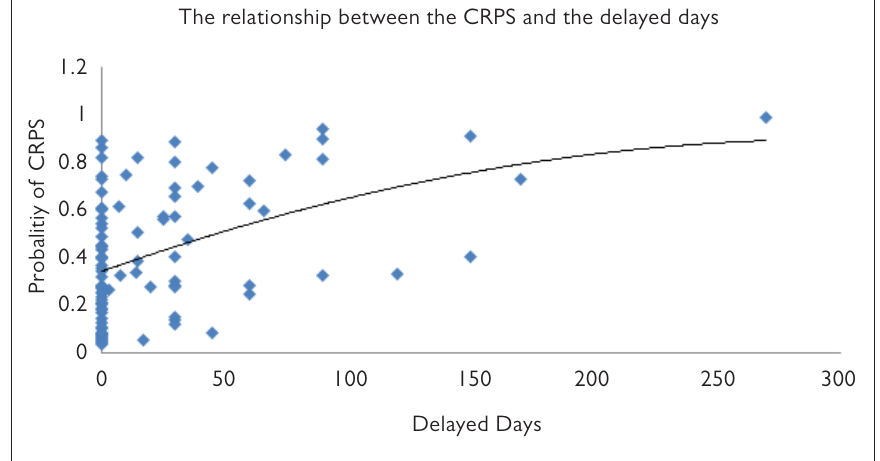
The relationship between the CRPS and the delayed days